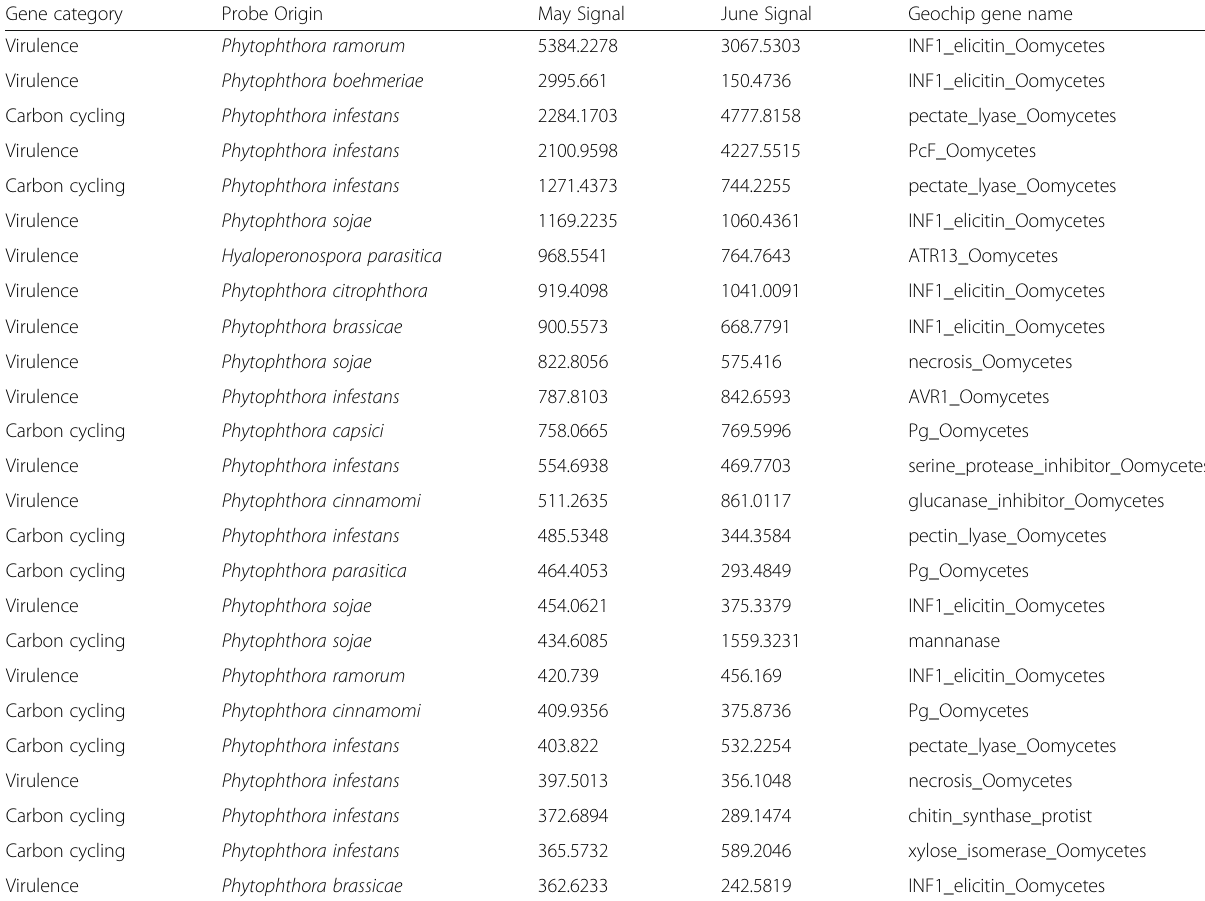
Table 2 GeoChip 5.0 probe data displaying the top-25 most abundant (proxied by probe intensity) genes in May and June sediment from Barrow,